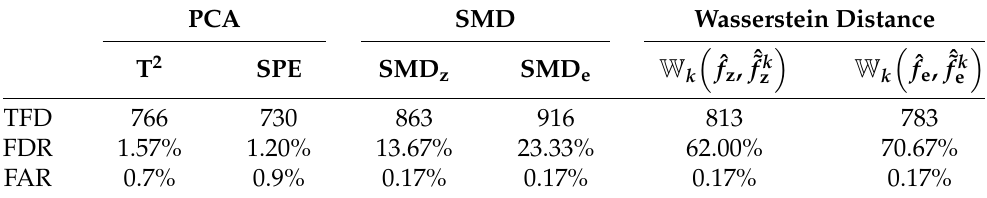
Table 1. Comparison of fault detection performance for the simulation example. PCA SMD Wasserstein